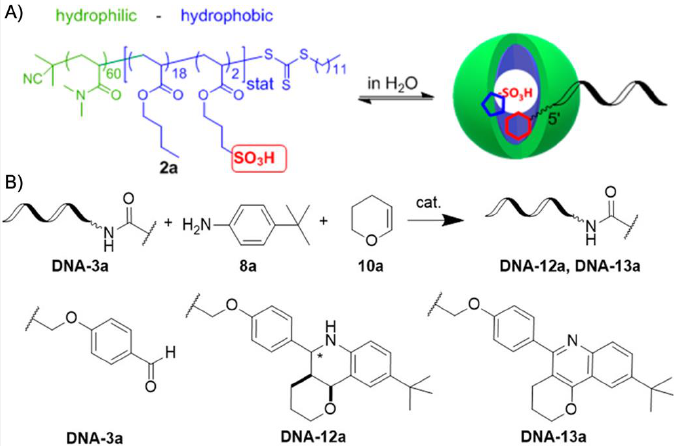
Figure 11. Micellar nanoreactor with Brønsted acid in the hydrophobic domain for the catalysis of DNA-conjugated substrates in water. ( A ) Chemical structure of the amphiphilic BCP and self-assembly to micelles in water with reactive sites for DNA conjugation in the core. ( B ) Povarov reaction of 14mer DNA-benzaldehyde with p - tert- butyl-aniline and 3,4-dihydro-2H-pyran to a substituted tetrahydrochinoline. Adapted with permission of [124]. Copyright 2019 American Chemical Society.